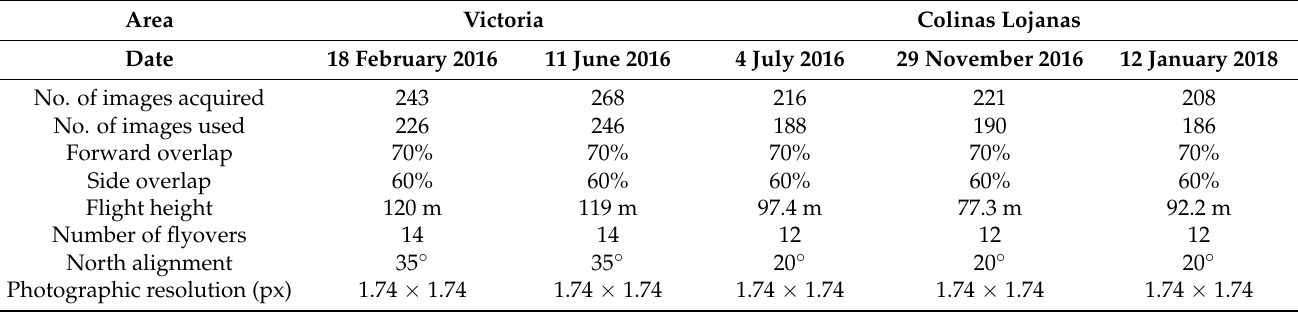
Table 2. Design parameters used to generate the flight paths in the study